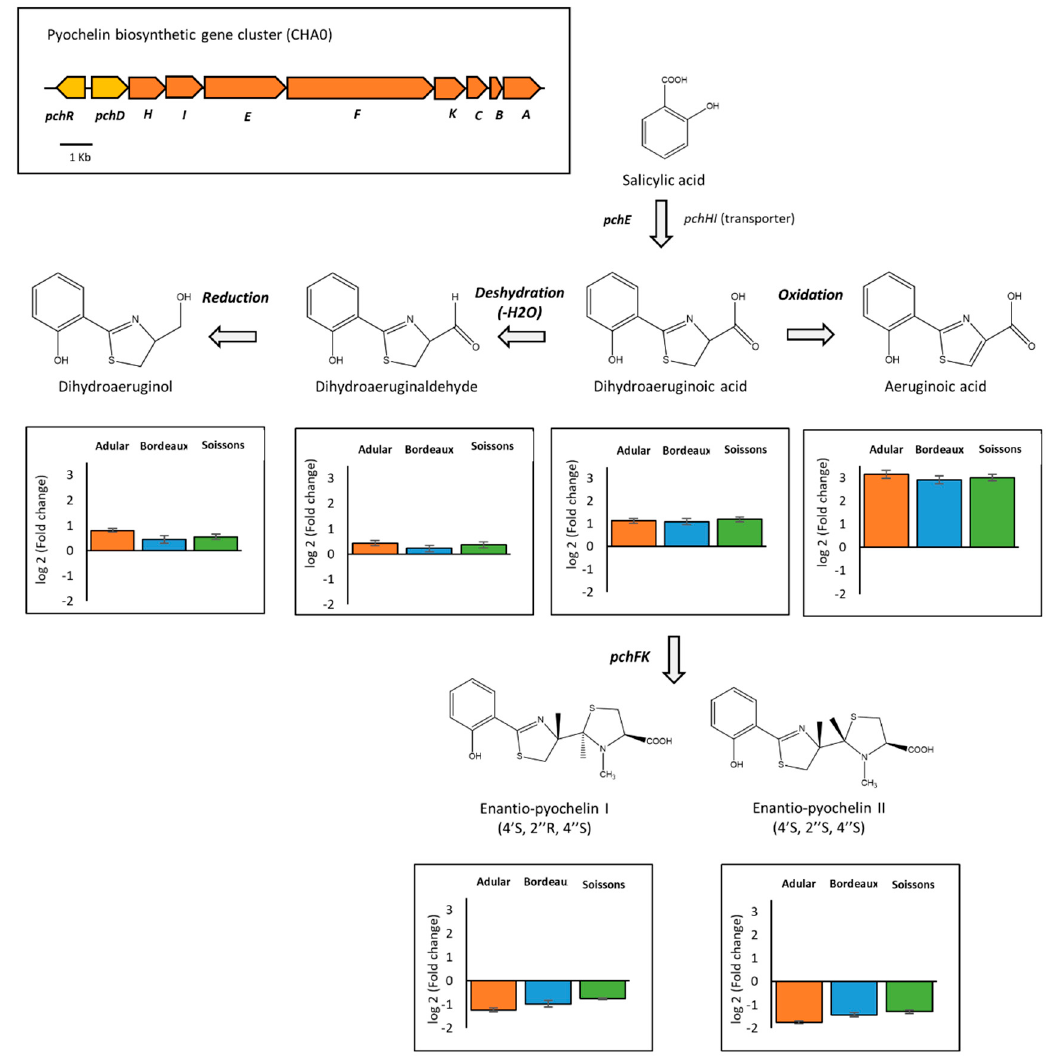
Figure 5. Plant metabolites interfere with the biosynthesis of pyochelin. The figure shows the pyochelin biosynthetic pathway (adapted from Ye et al. 2014 [30]), the organization of the pyochelin biosynthetic operon in Pseudomonas protegens CHA0, and the relative intensities (Log2 fold changes) of metabolites of Pseudomonas cultivated in the presence of wheat root extracts compared to the control condition (culture in the absence of root extracts) (n = 5 replicates).